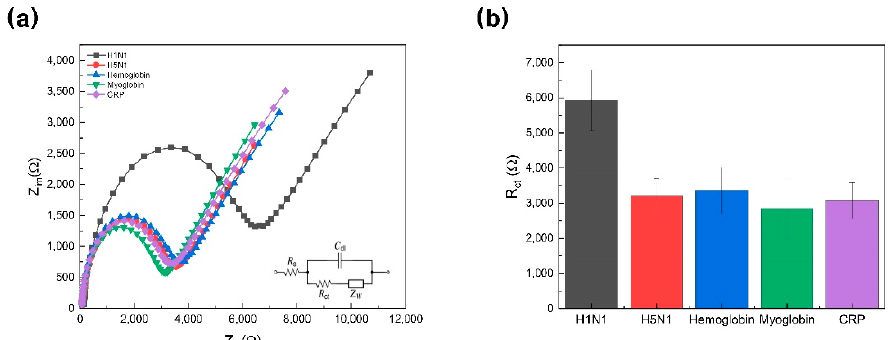
Figure 6. ( a ) Impedance spectra of proposed biosensor with various targets (100 nM), including H1N1 (black line), H5N1 (red line), hemoglobin (blue line), myoglobin (green line), and CRP (purple line) in 5 mM [Fe(CN) 6 ] 3 − /4 − solution in 10 mM HEPES (pH 7.04) containing 1 M KCl. ( b ) Change in charge-transfer resistance based on selectivity test (error bars: standard deviation). CRP, C-reactive protein; HEPES, 4-(2-hydroxyethyl)-1-piperazineethanesulfonic acid.